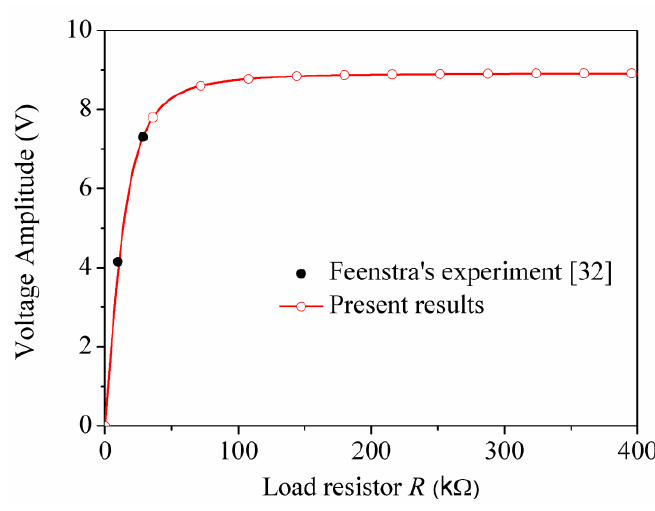
Figure 8. The voltage amplitude changes with the load resistor.